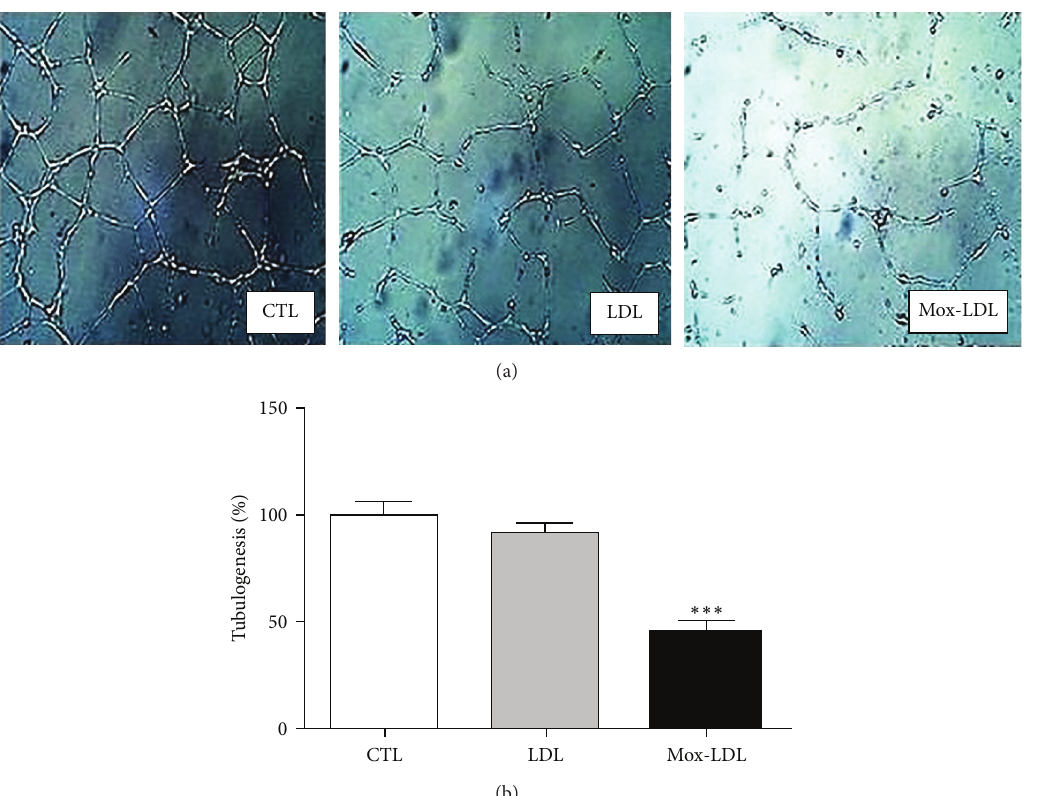
Figure2:TheeffectofMox-LDLtreatmentonHUVECtubulogenesis.(a)RepresentativefieldsofHUVECculturesintubulogenicconditions. HUVECs were seeded on Matrigel supplemented with mock medium (CTL), native LDL (LDL), or Mox-LDL (MoxLDL) and incubated overnight. The fields are representative of three independent experiments performed in duplicate. (b) Quantification of tubulogenesis in HUVEC cultures. After overnight incubation in Matrigel supplemented with mock medium (CTL), native LDL (LDL), or Mox-LDL (Mox- LDL), pictures were taken of 4.906 mm square fields. Total tubule network length was then measured using the Image J computer program. Shown data are expressed as total tubule network length for each condition and normalized to the untreated control set as 100%. Mean ± SEM on 3 independent experiments performed in duplicate. ∗∗∗ 𝑃 < 0.001 versus control (ANOVA, Turkey’s multiple comparison